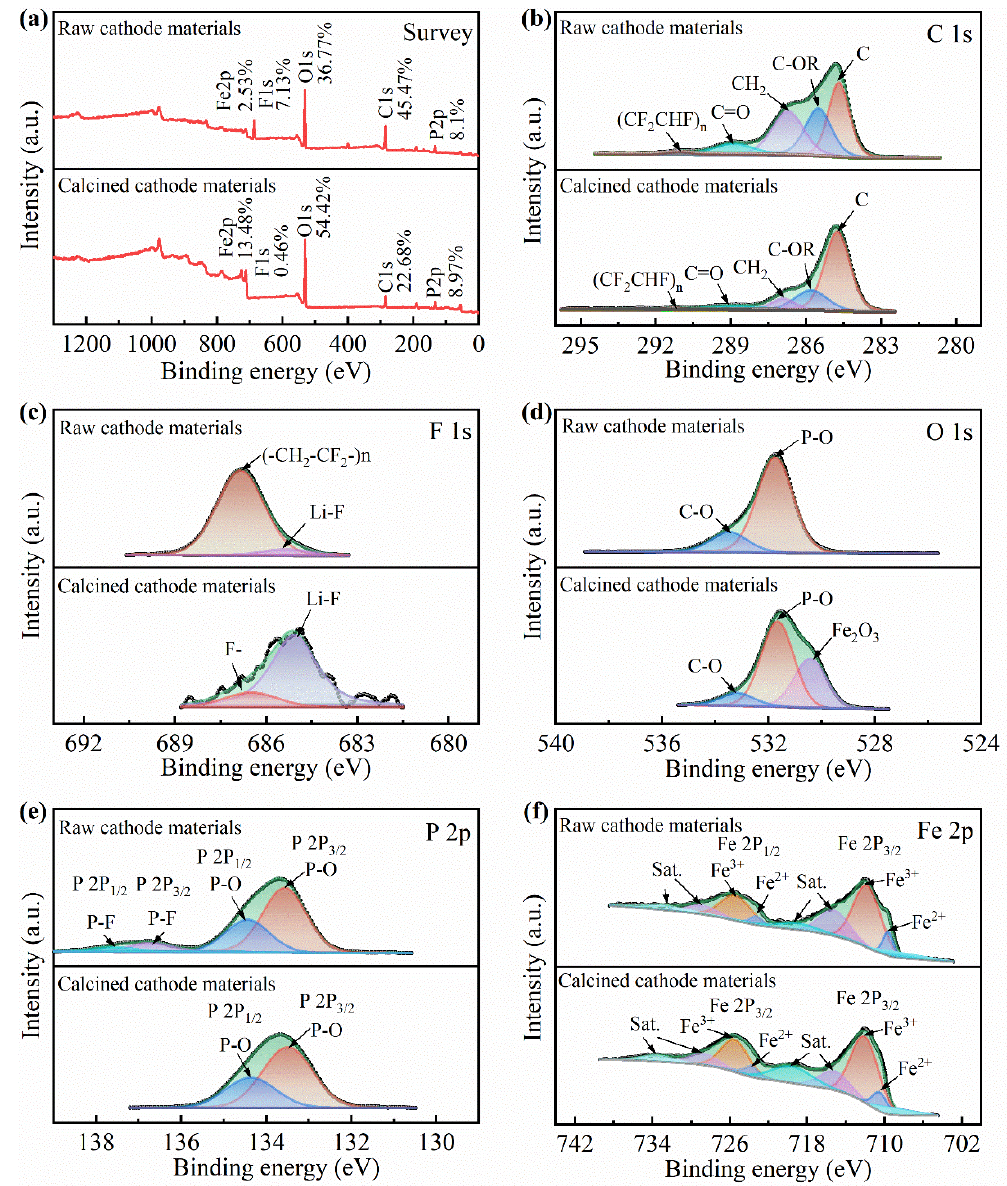
Figure 13. Comparison of ( a ) the full XPS spectrum, ( b ) C 1s, ( c ) F 1s, ( d ) O 1s, ( e ) P 2p, and ( f ) Fe 2p in the raw cathode materials and the calcined cathode materials under optimized condition.